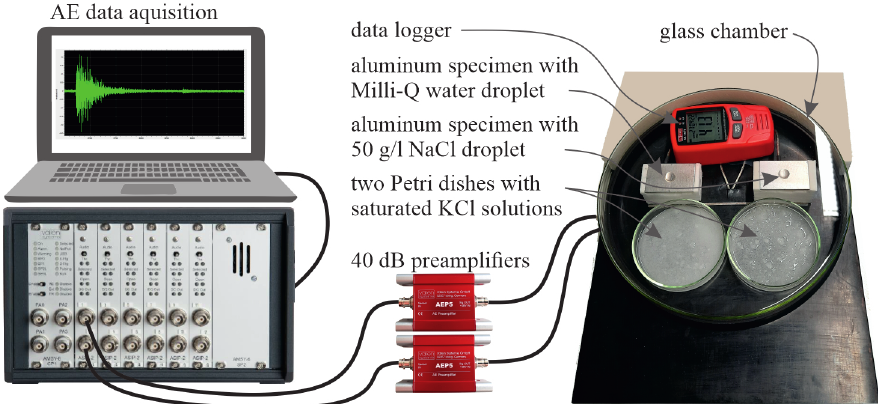
Figure 4. Experimental setup of the AE source identification experiment to compare the AE caused by the droplets of Milli-Q water and NaCl solution,